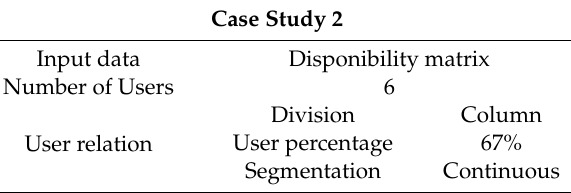
Table 8. Example of a collaborative model adjustment—Case Study 2.